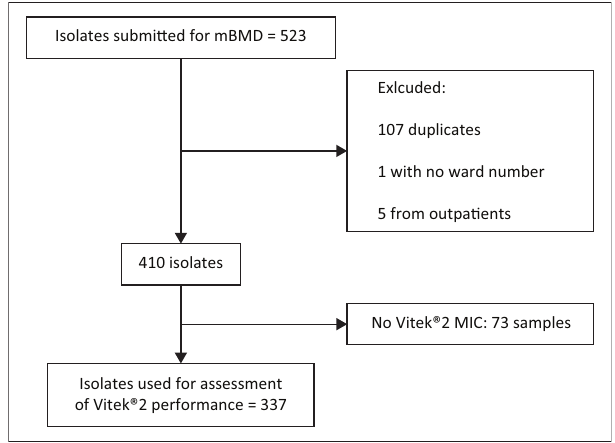
FIGURE 1: Isolate selection and inclusion for Vitek®2 colistin susceptibility